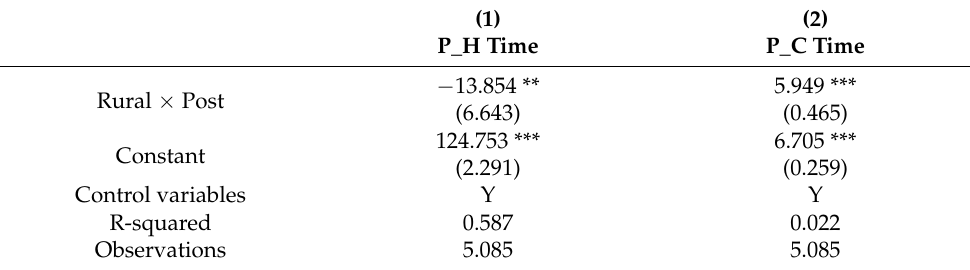
Table 7. Mechanism analysis: impact of the household technology on parental time